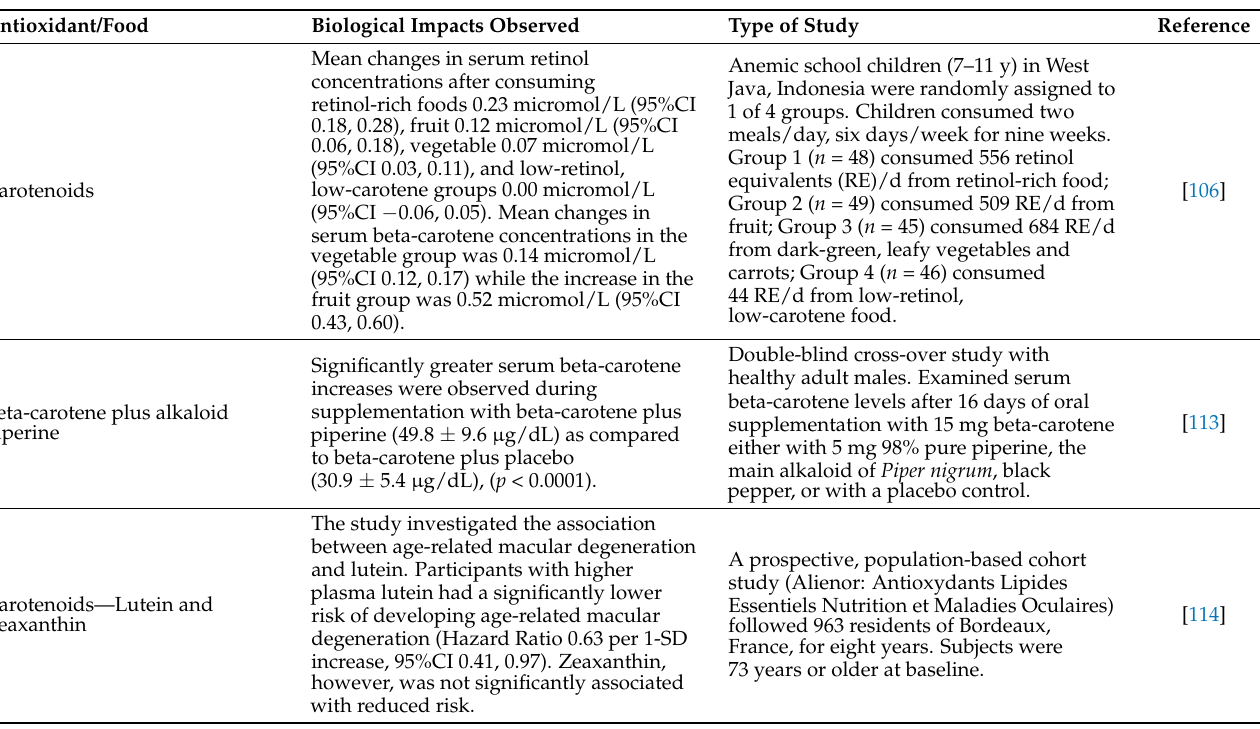
Table 4. Parameters and pertinent results from cited studies examining health outcomes associated with various